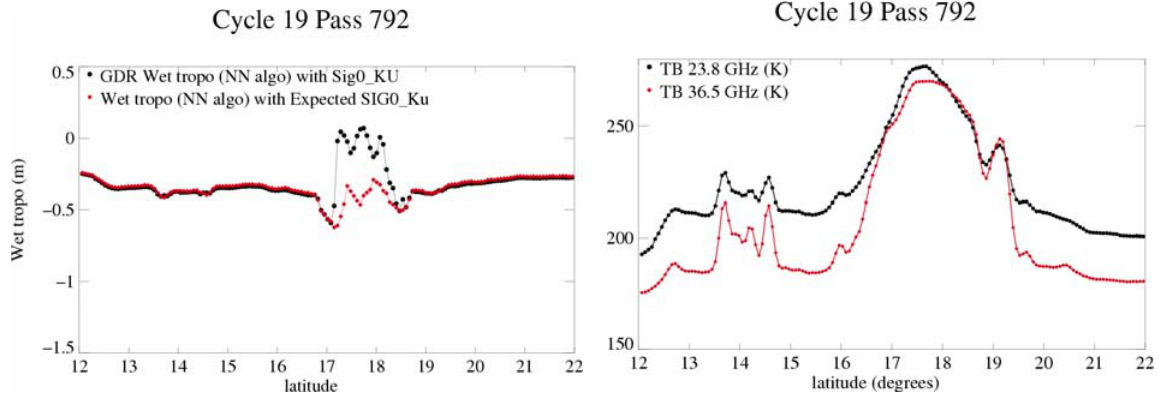
Figure 8. Values of the wet tropospheric corrections computed with Neural Network algorithm with SIG -Ku from GDR (black) and “expected” SIG 0 of TBs